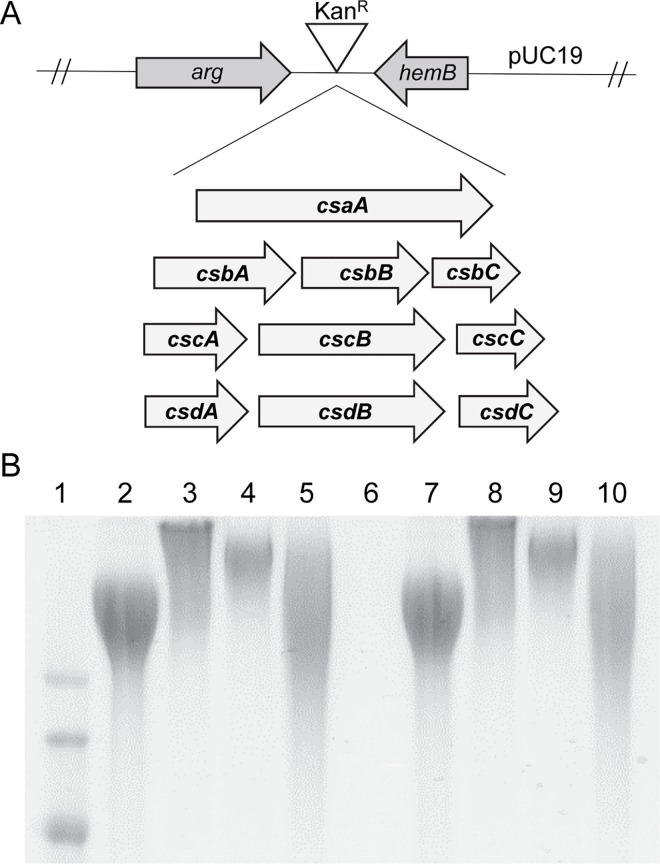

(A) Illustration of the capsule swap vector in pUC19 harboring the csa, csb, csc, or csd locus with a Kan
R
marker for selection, and (B) the migration patterns of capsule material from isogenic capsule swaps. Alcian blue stained gel depicting the migration pattern of capsule material purified from the surface of the source strains (lanes 2–5) and the capsule swaps expressed in the isogenic KK01 background (lanes 7–10). Lane 1, ladder; lane 2, KK01; lane 3, PYKK58; lane 4, PYKK60; lane 5, PYKKBB270; lane 6, KK01Δcsa; lane 7, KK01Swapcsa; lane 8, KK01Swapcsb; lane 9, KK01Swapcsc; lane 10, KK01Swapcsd.